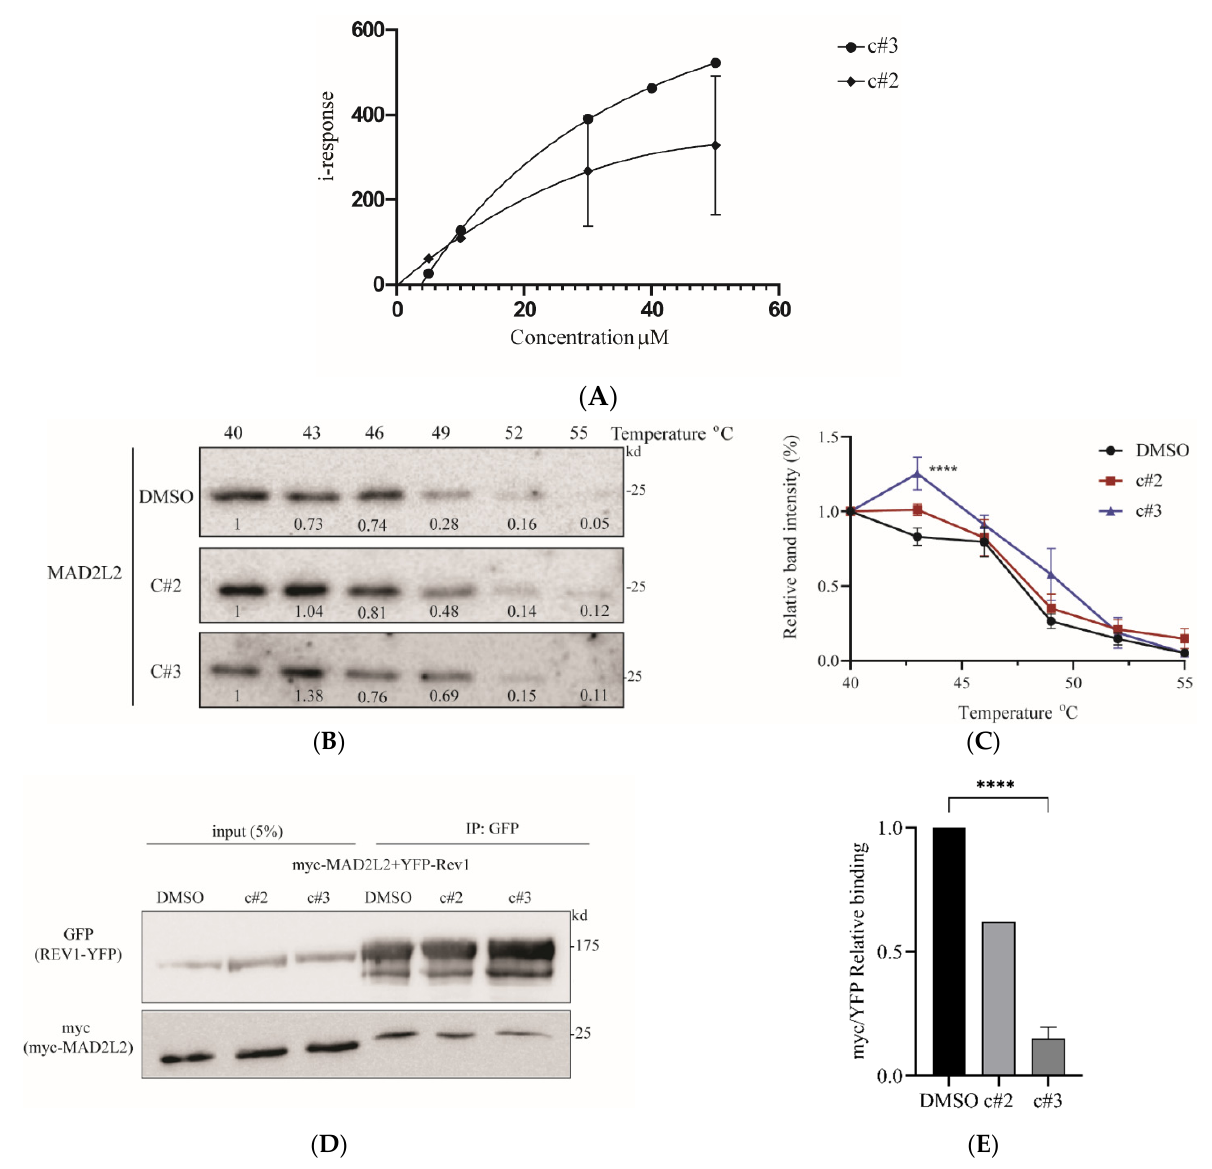
Figure 5. Compounds #2 and #3 reduce Rev1-MAD2L2 interaction. ( A ) Binding activity of the compounds c#2 and c#3 to MAD2L2 in vitro. Binding assay of increasing concentrations of compounds c#2 and c#3 to MAD2L2. c#2 k D = 310.8 ± 32.96 μ M; c#3 k D = 44.88 ± 2.062 μ M. ( B ) MAD2L2 ′ s cellular thermal shift assay (CETSA) in 293T cells after 1-h treatment with DMSO or 50 μ M of c#2 or c#3. Relative MAD2L2 levels at each temperature compared to DMSO are indicated. ( C ) Aggregation curve generated by quantification and comparison of MAD2L2 in each cellular thermal shift assay. n = three independent experiments. p- value < 0.0001 (****) was calculated for row factor of c#3 compared to DMSO using a two-way ANOVA. The additional blots contributing to this analysis are shown in Figure S2A. ( D ) HEK293 cells were co-transfected with YFP-Rev1 together with myc-MAD2L2, and an α -GFP IP was performed to assess Rev1-MAD2L2 binding when treated with 50 μ M of each compound. ( E ) Quantification of the relative amount of myc-MAD2L2 bound to YFP-Rev1. For DMSO and c#3 n = 3 independent experiments, for c#2 n = 1 independent experiment, SD = 1, error bars represent 1 SD. p -value< 0.0001 (****) was calculated by two-tailed t -test. The additional co-IP blots contributing to this analysis are shown in Figure S2B.